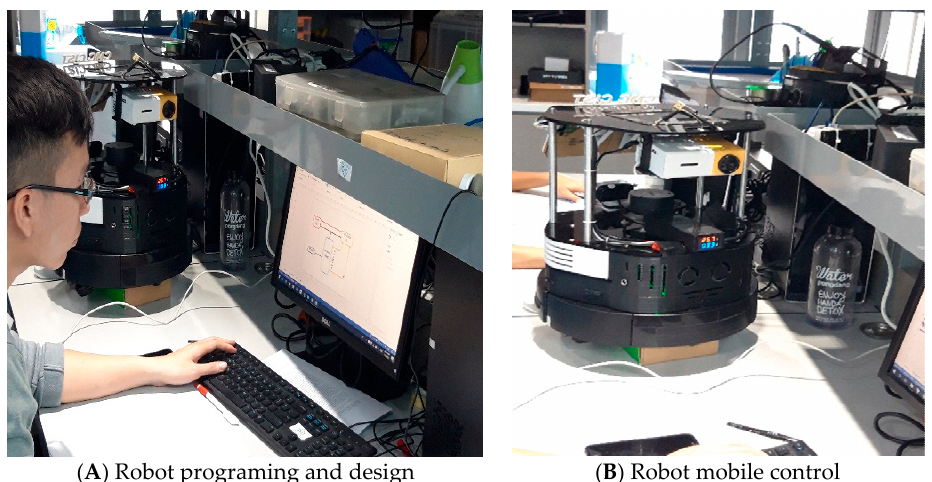
Figure 9. A sample of a monitoring robot with multiple directions in regular and irregular obstacles at the CIST Lab.